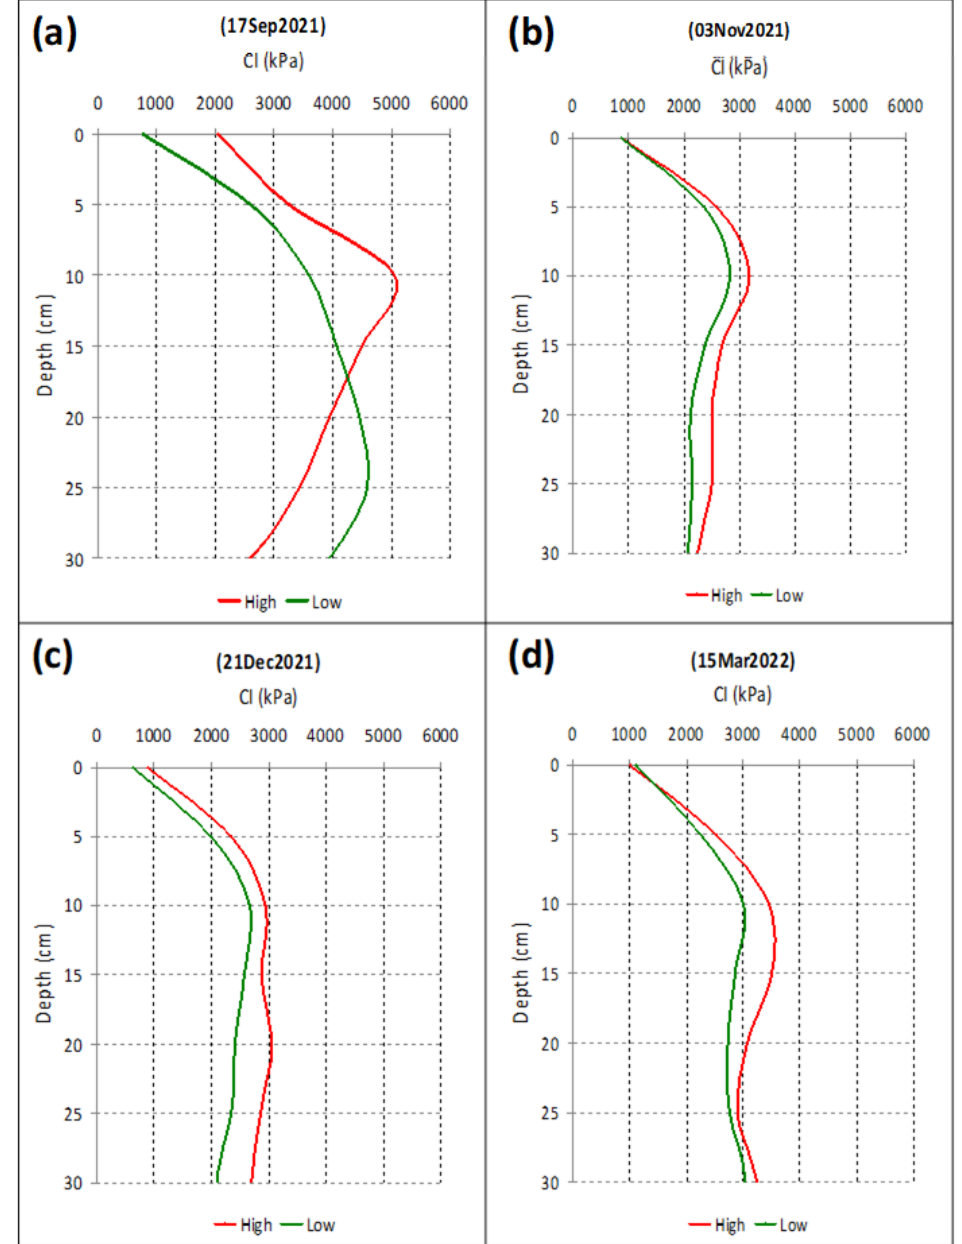
Figure 16. Average Cone Index (CI) at 0–0.30 m soil depth, in high and low-grazing-intensity areas: ( a ) 17 September 2021; ( b ) 3 November 2021; ( c ) 21 December 2021; ( d ) 15 March 2022.